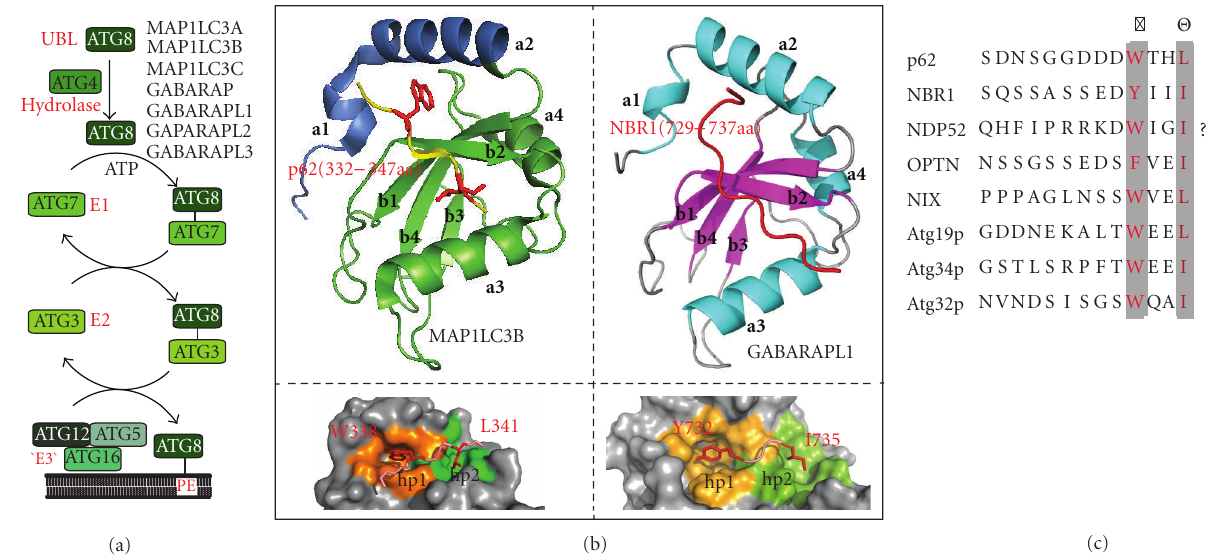
Figure 2: (a) ATG8 conjugation cascade. (b) Structures of MAP1LC3B/p62-LIR (upper left; pdb code: 2K6Q) and GABARAPL1/NBR1- LIR (upper right; pdb code: 2ZJD) complexes. LIR binding sites of MAP1LC3B (lower left) and GABARAPL1 (lower right). (c) Sequence alignments of functional LIR motifs in autophagy